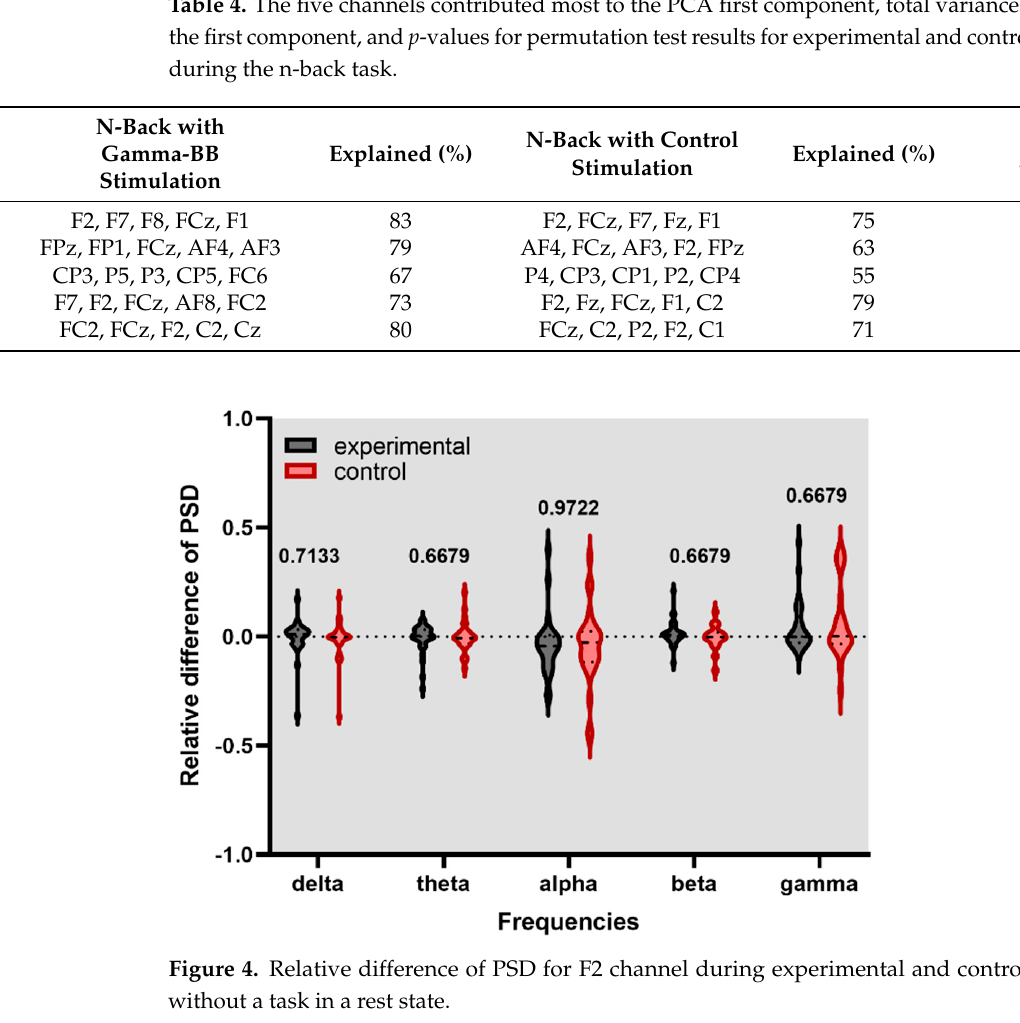
Table 4. The five channels contributed most to the PCA first component, total variance explained by the first component, and p -values for permutation test results for experimental and control stim- ulation during the n-back task.